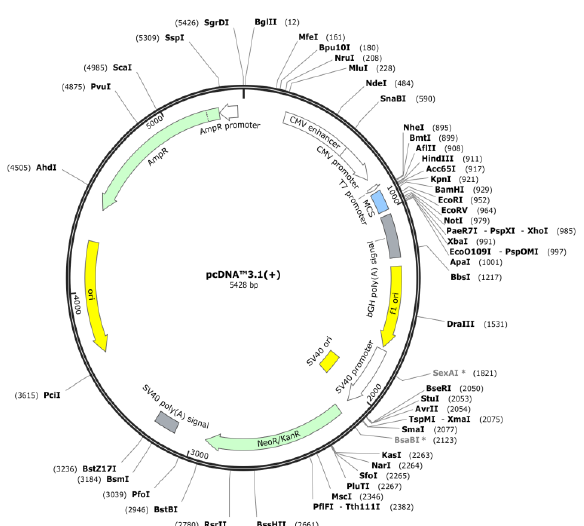
Figure 1. The map of pcDNA3.1(+)